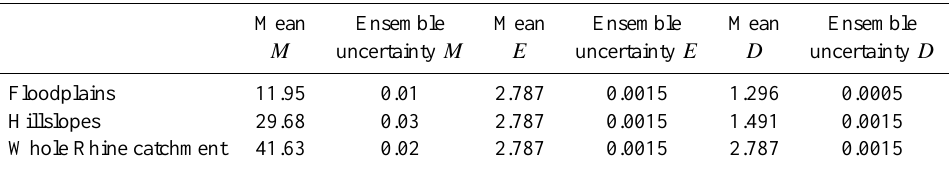
Table 5. Summary of sediment storage M (Gt), erosion ( E ) and deposition ( D ) rates in tha − 1 year − 1 , and the related uncertainty ranges for the Rhine catchment for the period AD850–2005. The uncertainty values represent the range in the mean values due to different ensemble